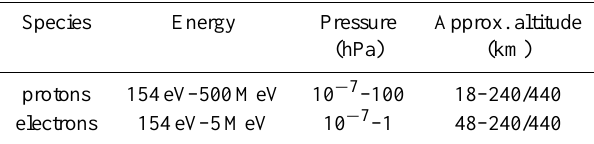
Table 2. AIMOS particle energy ranges and the corresponding pres- sure and altitude levels. As the upper altitude border for protons and electrons lies in the thermosphere, it varies by solar activity. The first number indicates solar minimum conditions while the second number represents solar